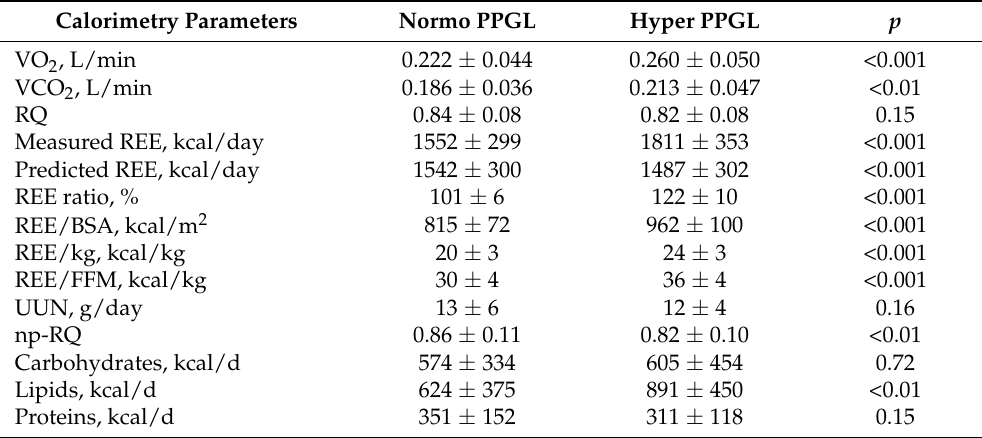
Table 4. Results from indirect calorimetry between normo and